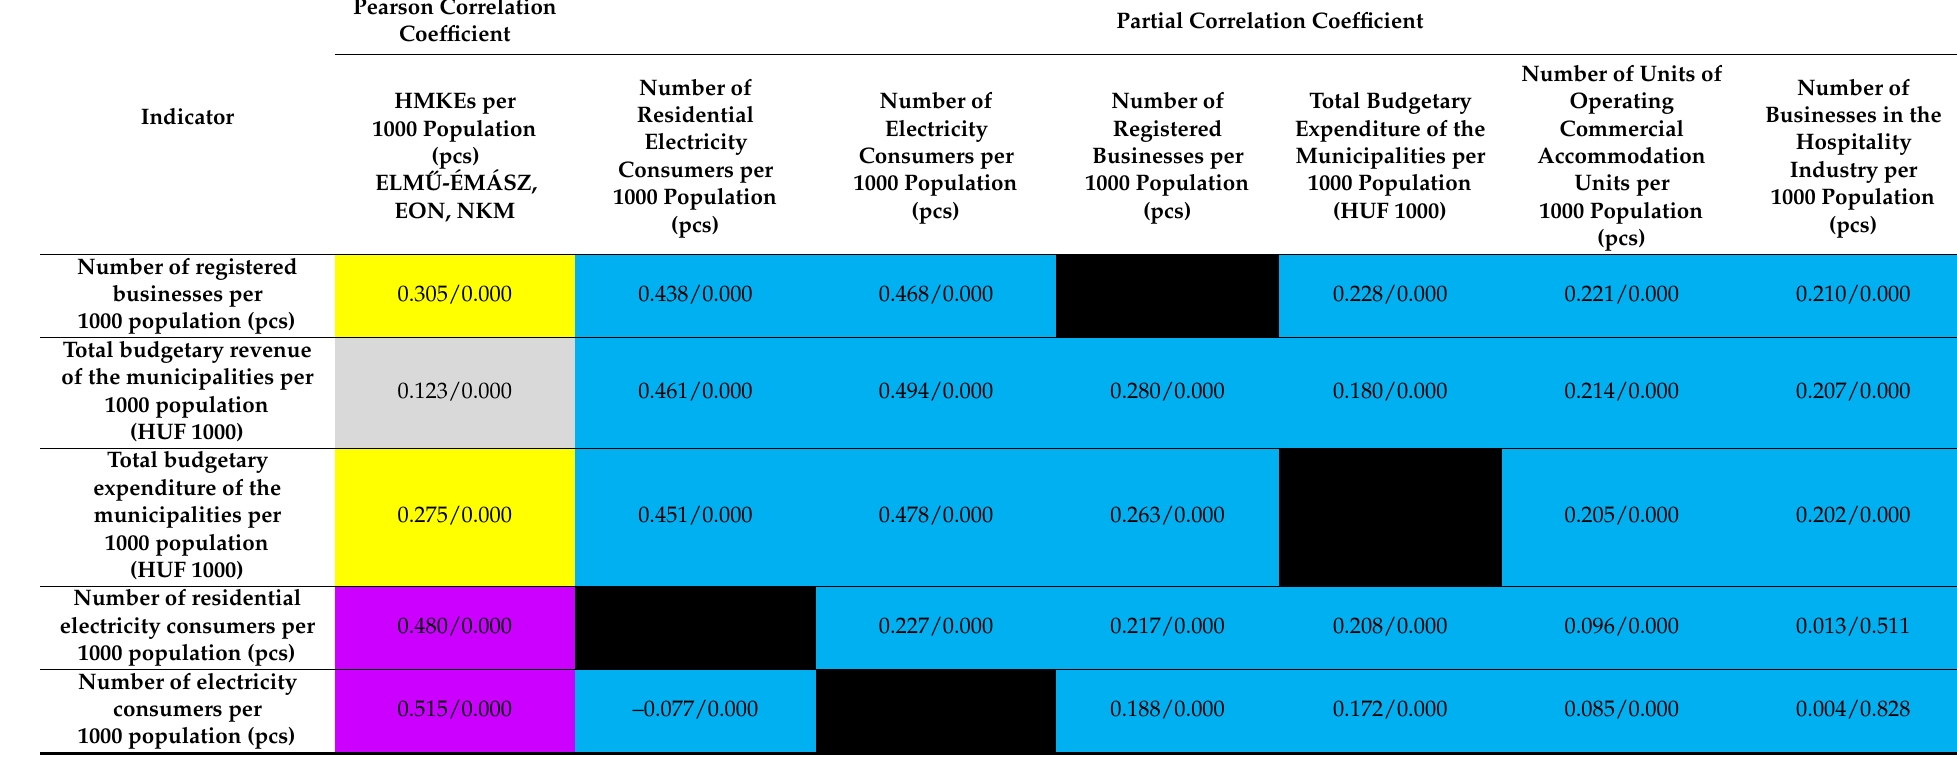
Table 2. The strength of the relationship between the quantity of the total HMKEs per 1000 population and the settlement indicators 1 ( 1 Pearson correlation coefficient/ p -value; if p < 0.05, then there is a significant verified relationship between the two variables) (In the case of the Pearson correlation coefficients in the table grey background indicates weak correlations, yellow means weak moderate, and purple moderately close ones. In the case of the partial correlation the blue background signals partial explanation (the controlled variable explains the relationship between variables i and j only partially), while the black one shows irrelevant